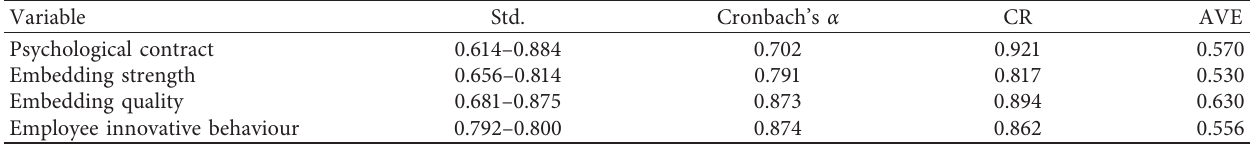
Table 2: Reliability and validity test.